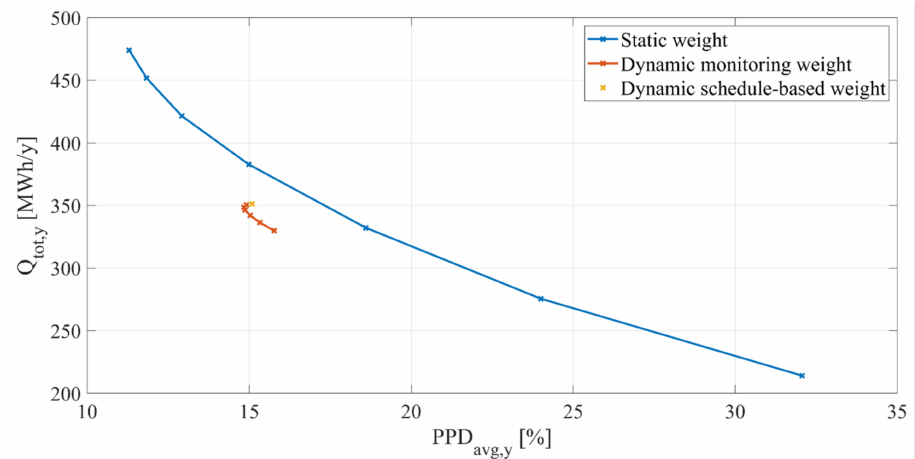
Figure 9. Results of the multi-objective optimization: Pareto frontiers of total energy demand and average percentage dissatisfied for static and dynamic weighting strategies.